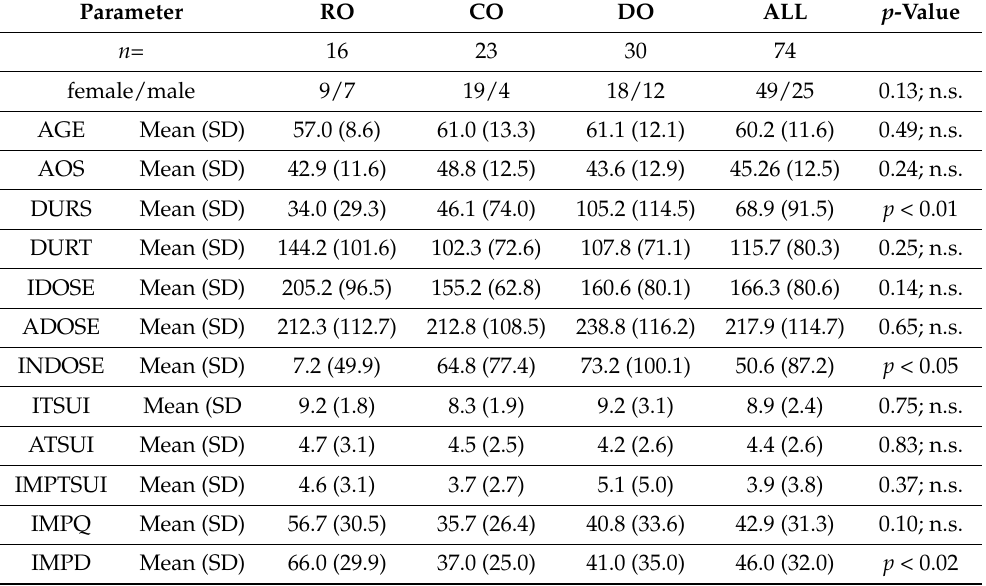
Table 1. Demographic- and treatment-related data and outcome measures in the three RO, CO, DO subgroups and the entire cohort.